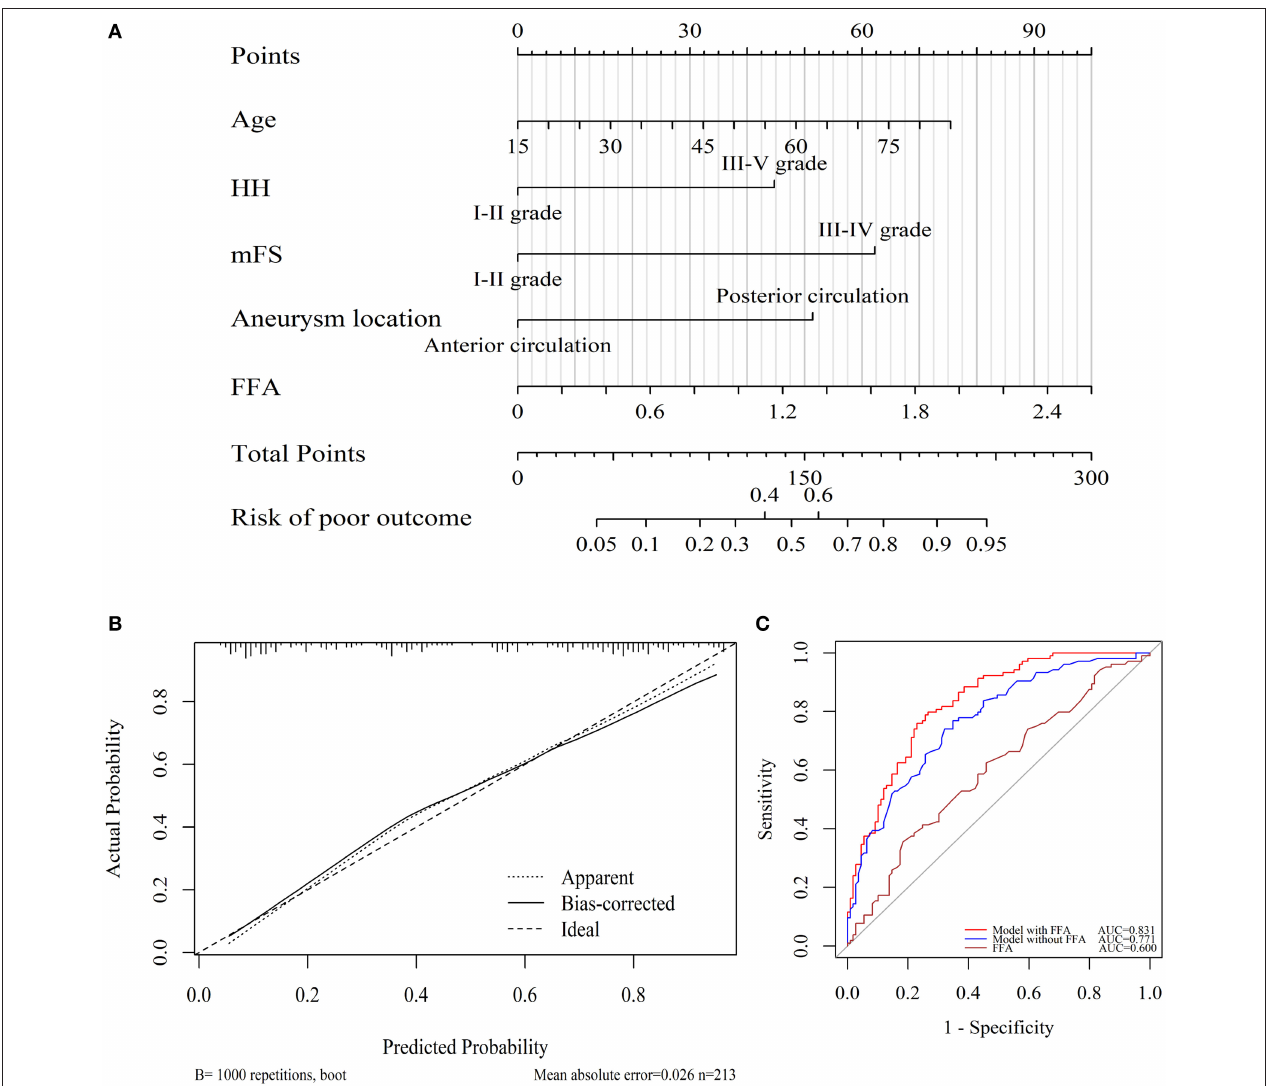
FIGURE 3 | Utility of nomogram for prediction of poor outcome at 3 months after endovascular-treated aSAH. (A) Points were assigned for age, HH grade, modified Fisher grade, aneurysm locations, and serum FFA levels on admission. The “total points” are the sum of the individual score of five significant clinical variables. (B) The calibration curve of the nomogram for 3 months poor outcome. The red line of 45 ◦ represented an ideal prediction and the dotted line represented the performance of this nomogram (Hosmer-Lemeshow test P = 0.76). (C) ROC curves showed a better prediction of clinical factors incorporating FFA level than the model consisted of age, HH, mFS, and aneurysm